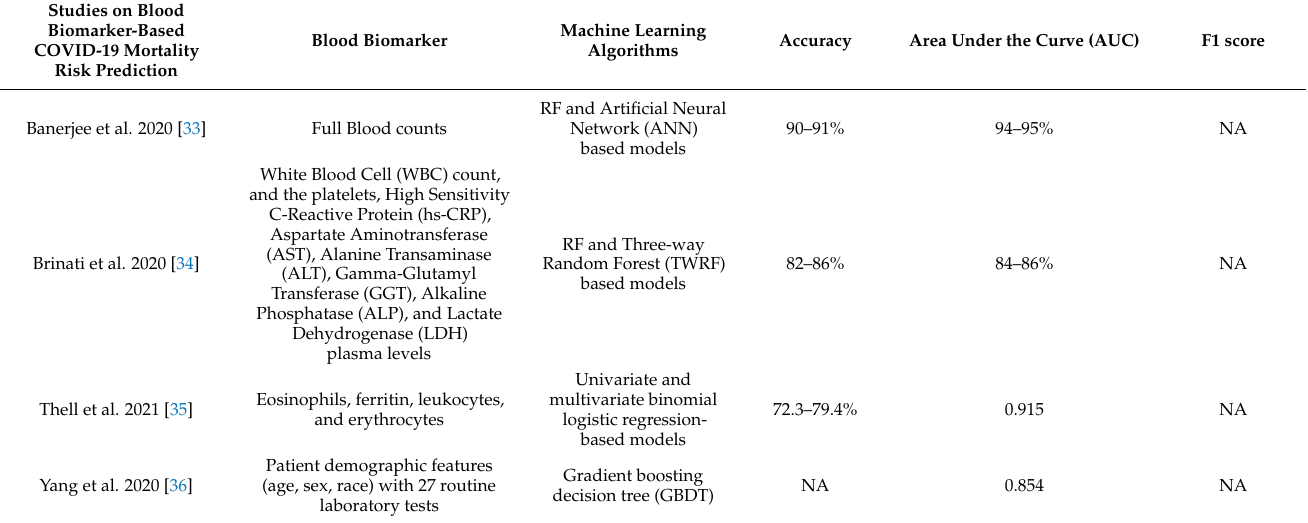
Table 1. Studies of blood biomarker-based COVID-19 mortality risk